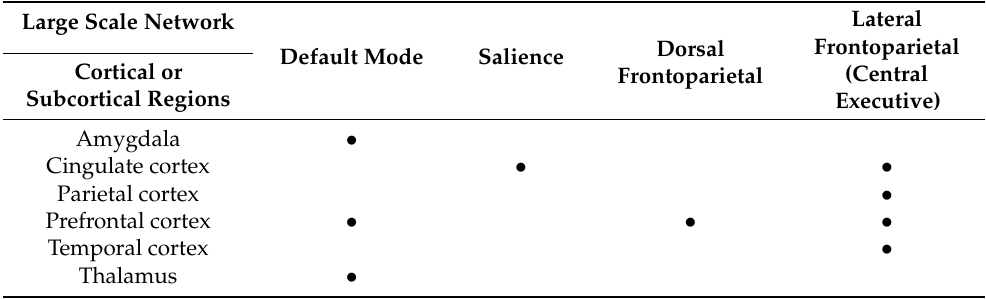
Table 1. Human cortical and subcortical brain regions with overlapping between hippocampal and large-scale brain networks’